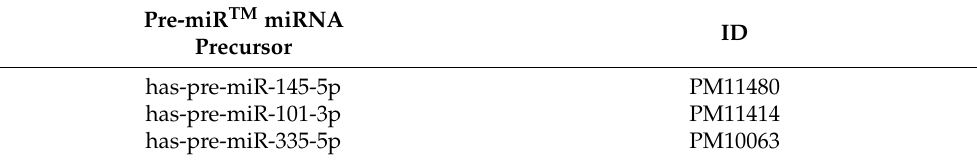
Table 1. The pre-miR miRNAs precursors list employed in Calu-3 and Caco-2 cell